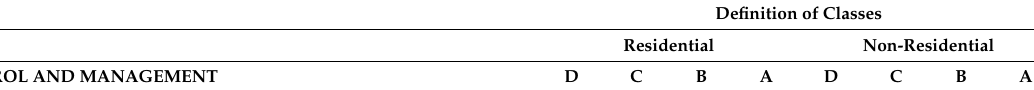
Table 4. Control function list of PV solar systems and possible assignment to BACS efficiency classes (the original author’s